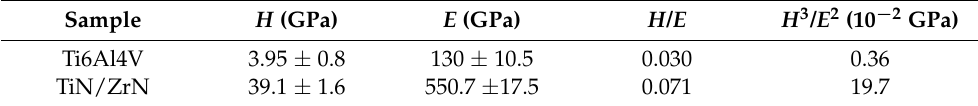
Table 3. Hardness and modulus of Ti6Al4V and the TiN/ZrN nanoscale multilayer coating.